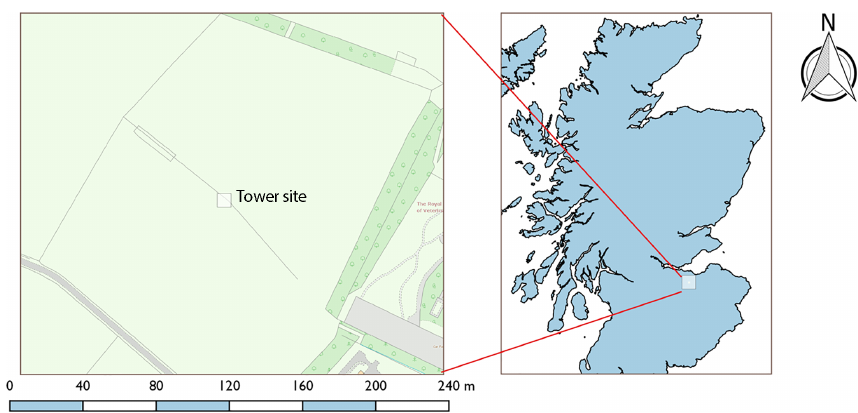
Figure 1. Location of the Bush Tower site (3 ◦ 12 (cid:48) W, 55 ◦ 52 (cid:48) N) in relation to surrounding agricultural land and within Scotland, UK.